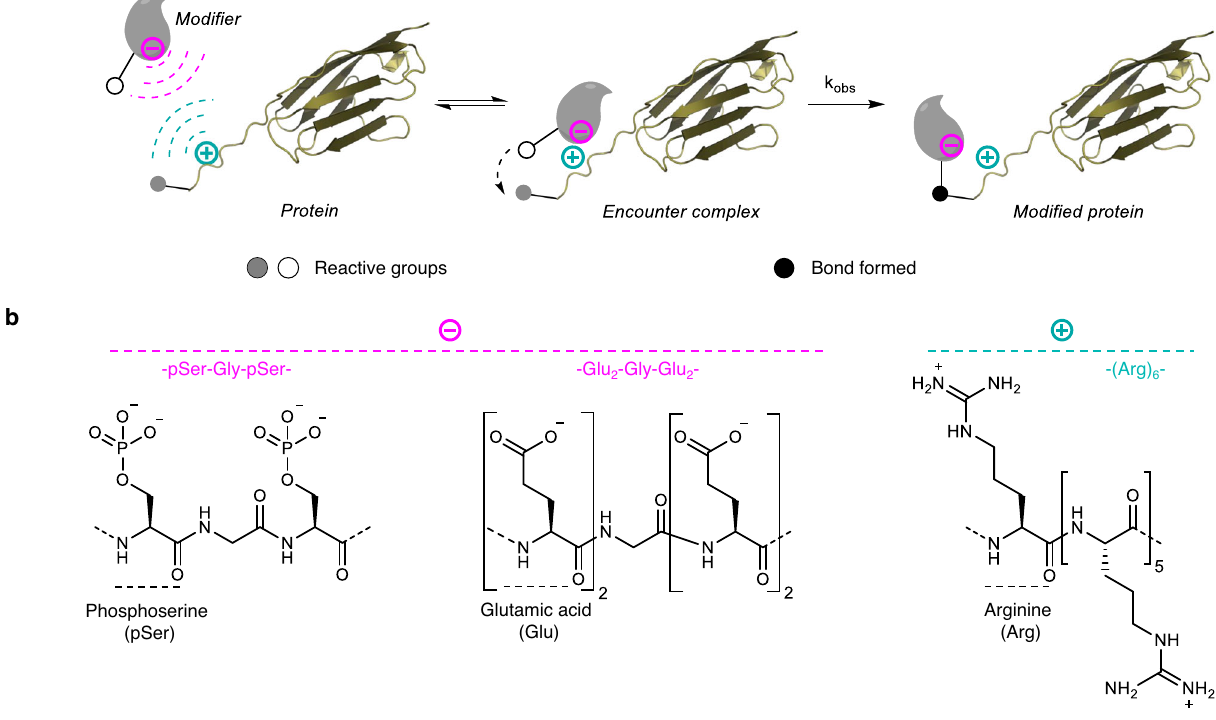
Fig. 1 | Electrostatic assistance of covalent protein modi fi cation. a Principle of electrostatic assistance. b Phosphoserine (pSer) or glutamic acid (Glu) residues